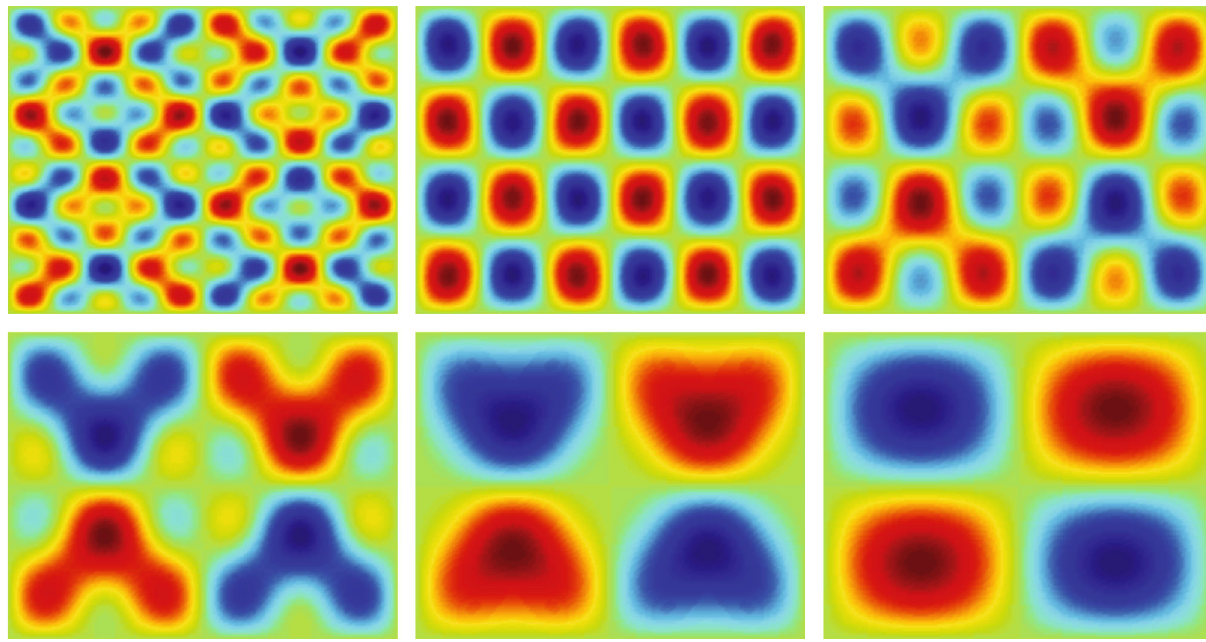
Figure 3: Solution snapshots of the BDF2 scheme (6) for the EFK equation using adaptive time strategy at t = 0, 0 : 1, 0 : 9, 1, 1 : 1, 15 ,